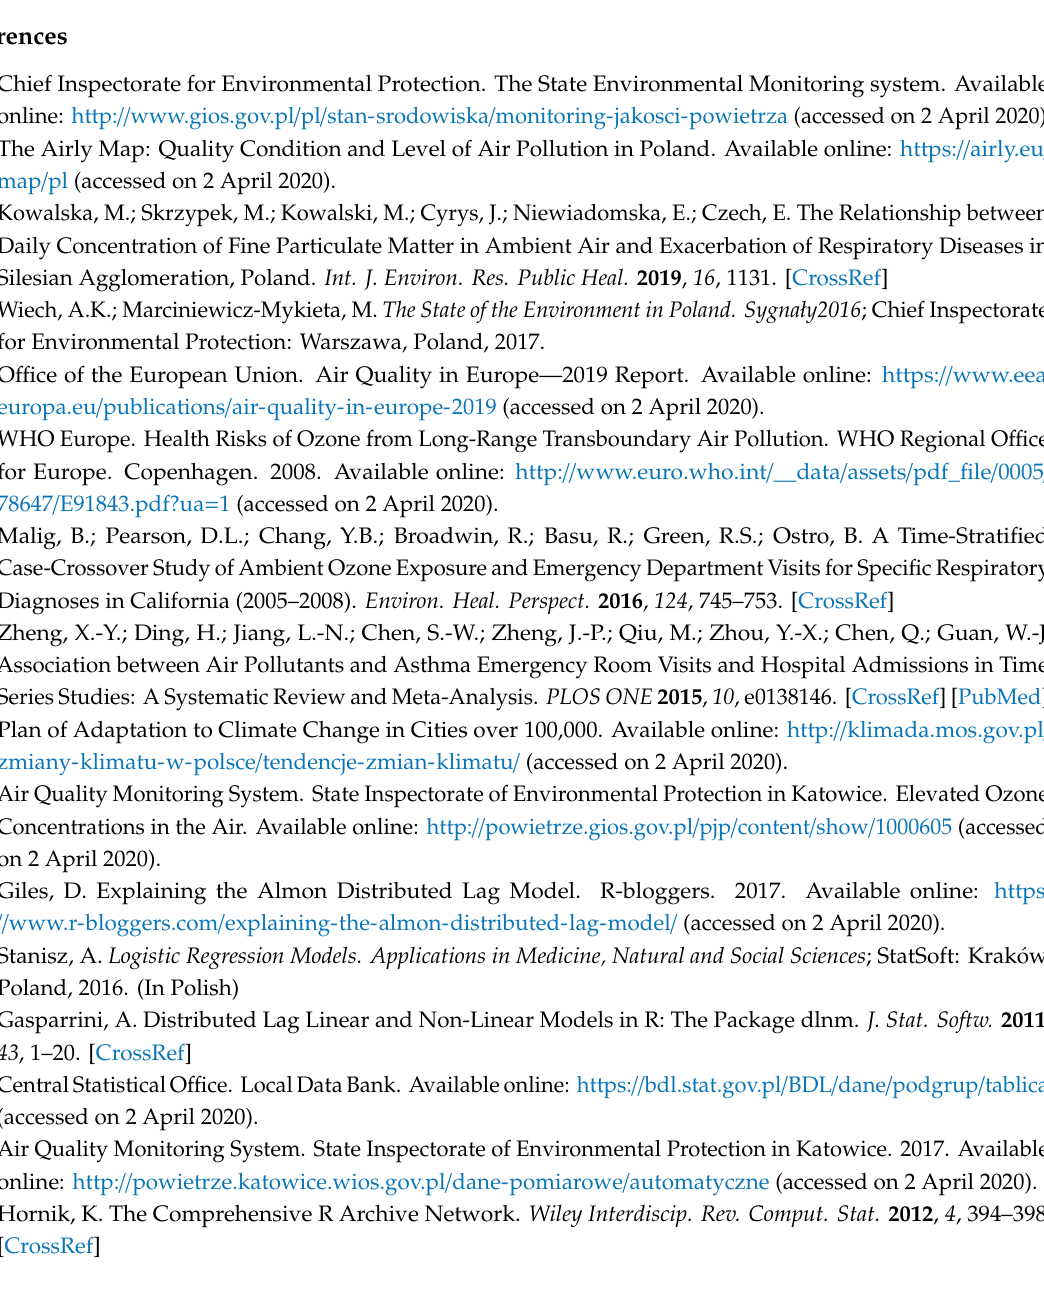
Figure S1. Total estimation of the daily number of hospitalizations y t ± SE due to: (a) bronchitis (J20–J21), (b) asthma (J45–J46), related to the level of concentration O 3 (8 h). Figure S2. Relative risk RR l of daily hospitalizations due to: (a) Bronchitis (J20–J21), (b) asthma (J45–J46), in the first days after exposure and associated with an 8 h ozone concentration increase by next unit (10 µ g / m3) compared to a normative value of 120 µ g /